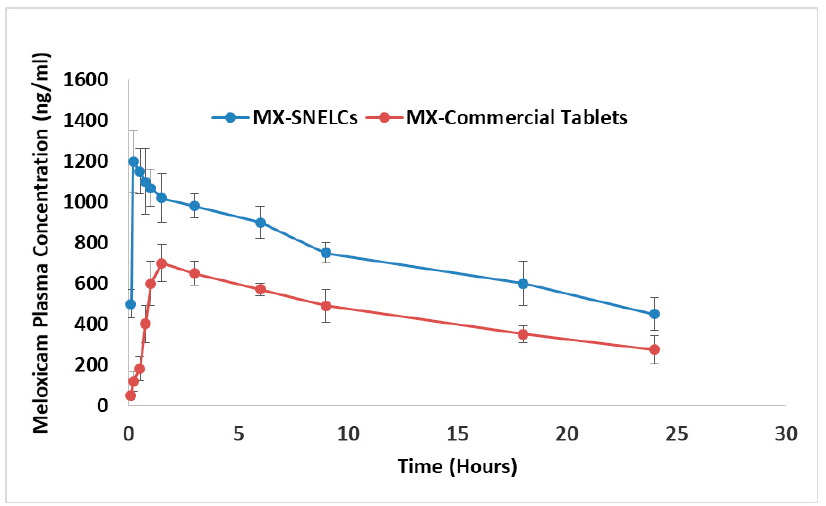
Figure 5. In vivo pharmacokinetics of lyophilized composite loaded with Meloxicam SNEDDS pre- pared with peppermint oil (MX-SNELCs) and marketed tablet of Meloxicam (MX commercial tablets). Table 10. Comparative pharmacokinetic parameters of optimized MX-SNELCs formulation and marketed tablets (mean ± SD, n = 6).